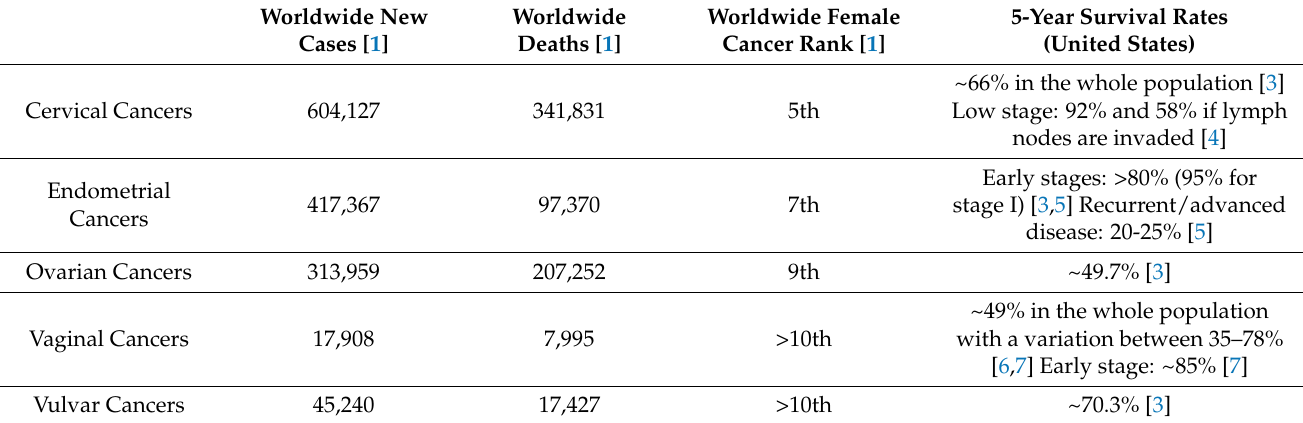
Table 1. Worldwide incidence and mortality rates of gynecological cancers in